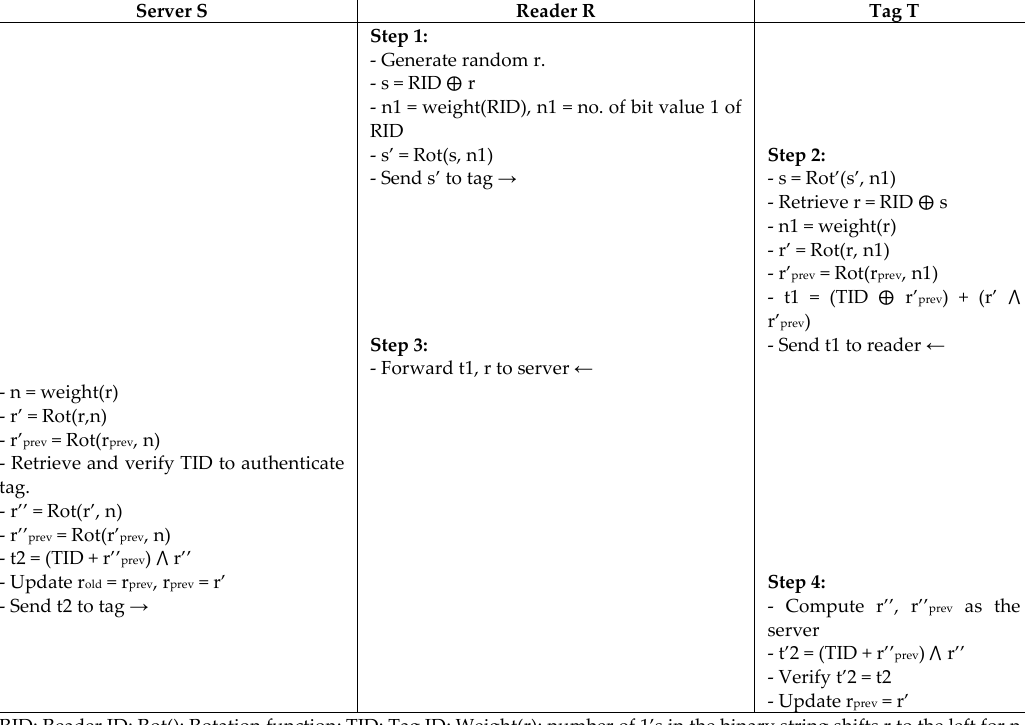
Figure 24. Improved Authentication Protocol (CWH+) by Aggarwal and Dass.